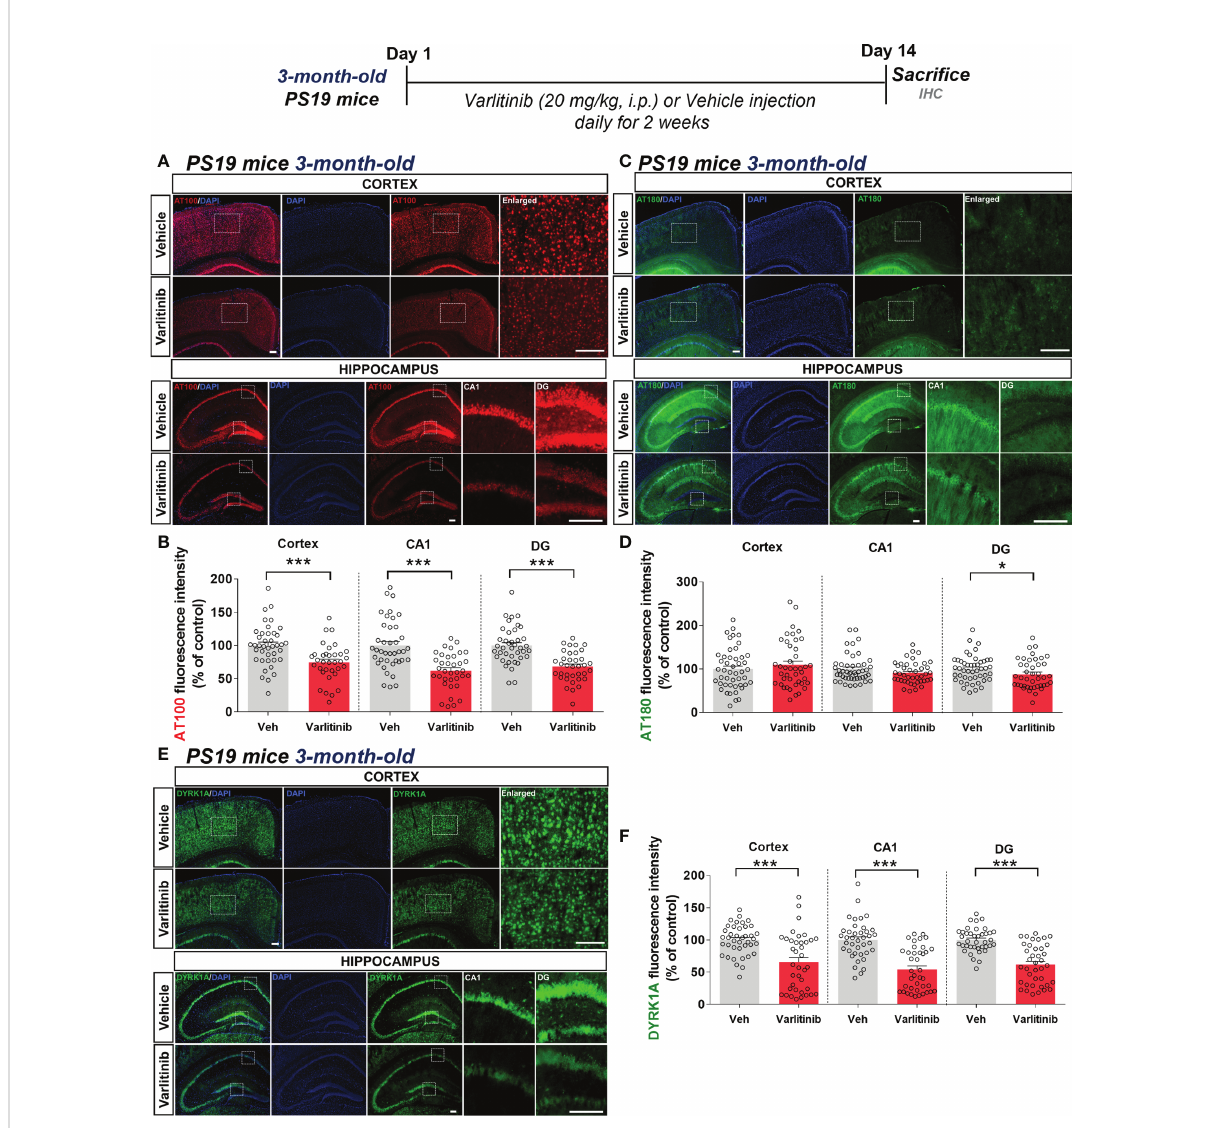
FIGURE 7 Varlitinib reduces tau hyperphosphorylation and tau kinase DYRK1A expression in 3-month-old tau-overexpressing PS19 mice. (A, C, E) Three- month-old tau-overexpressing PS19 mice were injected with varlitinib (20 mg/kg, i.p.) or vehicle (5% DMSO, 10% PEG, 20% Tween-80, i.p.) daily for 14 days, and immuno fl uorescence staining was conducted with anti-AT100, anti-AT180, and anti-DYRK1A antibodies. (B, D, F) Quanti fi cation of data from (A, C, E) (n = 11 mice/group, AT100: Veh: 40 brain sections, Varlitinib: 34 brain sections; AT180: Veh: 47 brain sections, Varlitinib: 42 brain sections; DYRK1A: Veh: 47 brain sections, Varlitinib: 42 brain sections, 2 experimental replicates per group). * p < 0.05, *** p < 0.001. Veh: Vehicle. Scale bar=50 m